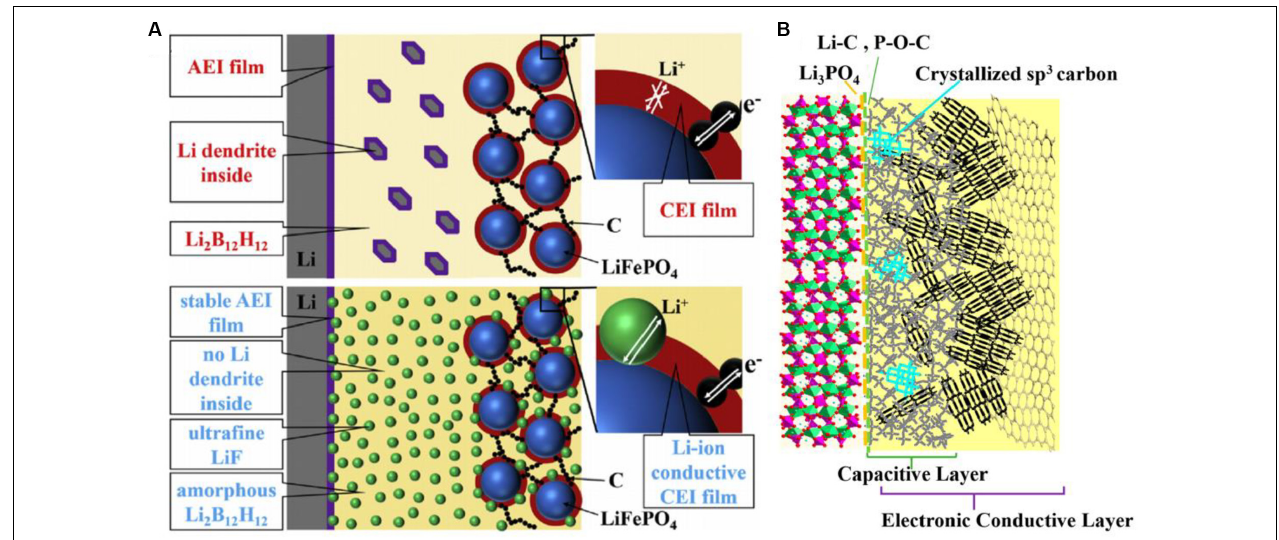
FIGURE 10 | Schematic illustration of electrode-electrolyte interface structure. (A) Schematic illustration for the functioning mechanism of the interface with composite solid electrolyte via in situ LiF nano-decoration of Li 2 B 12 H 12 . Ref. Shi et al. (2020). Copyright 2020 Elsevier. (B) Schematic illustration for the possible LVP-carbon interfacial structure of LVP/C composites. Reproduced with permission from Ref. Huo et al. (2019). Copyright 2019 American Chemical